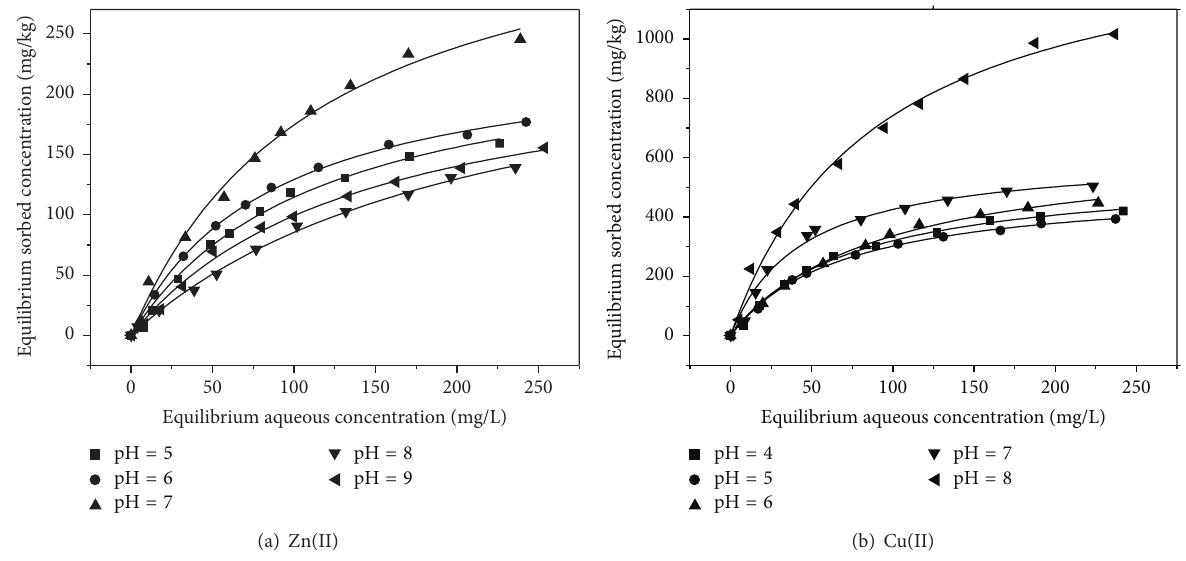
Figure 6: Adsorption isotherms for Zn(II) and Cu(II) on the modified clay under acid and alkali chemical solutions.